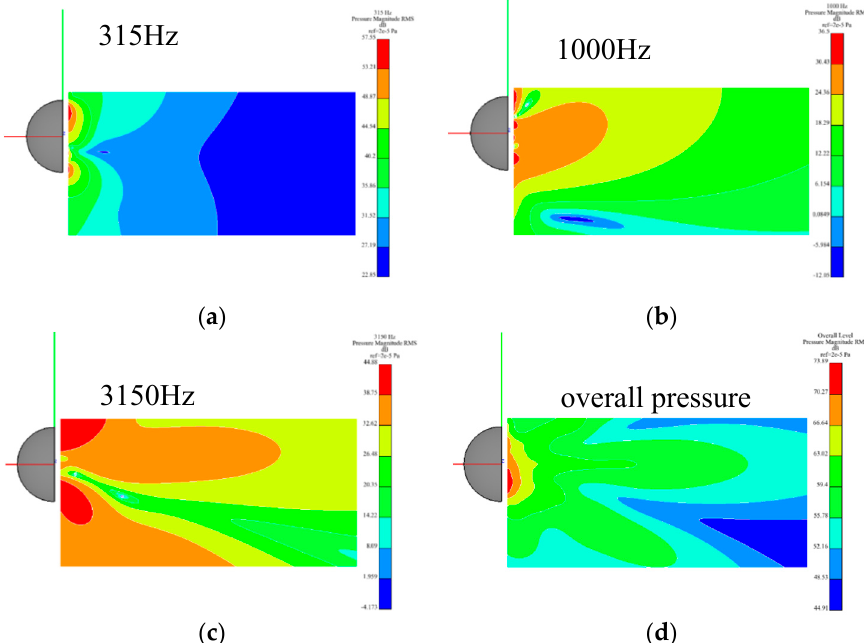
Figure 13. The pressure RMS distributions of the panel for 315 Hz, 1000 Hz, 3150 Hz and the overall pressure under the FSP of the side mirror: ( a ) For 315 Hz; ( b ) For 1000 Hz; ( c ) For 3150 Hz; ( d ) For the overall pressure.